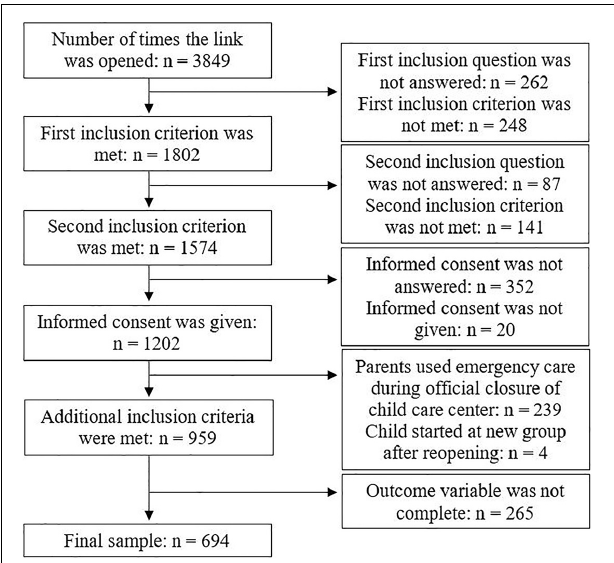
FIGURE 1 | Flow chart of the sample selection